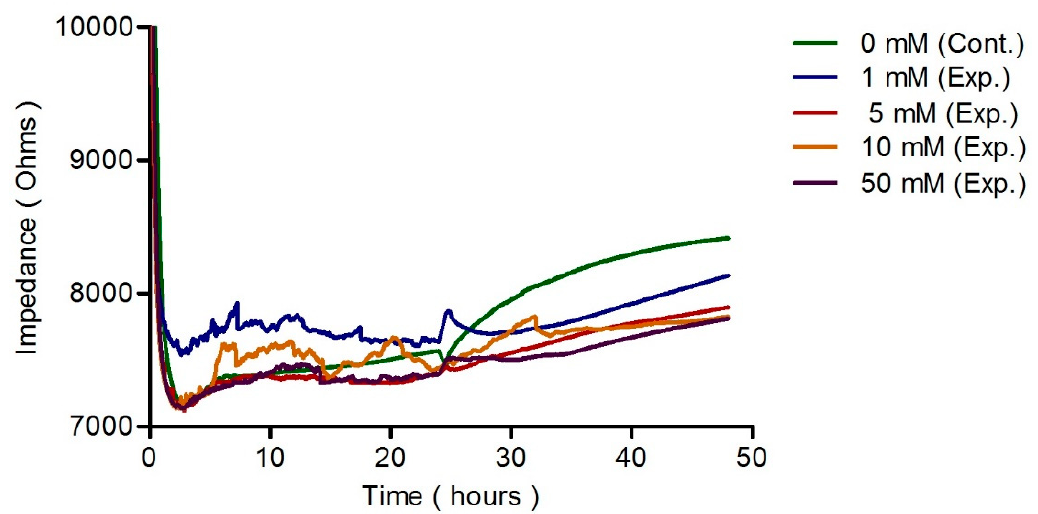
Figure 5. Real-time ECIS impedance results measuring cytotoxicity in hFOB 1.19 cells in response to different concentrations of Mg(OH) 2 NPs.